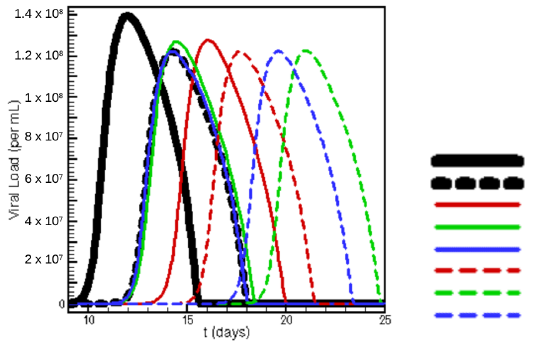
Figure 8. Viral load as a function of time for various treatment regimens. Each efficacy is 90% for Remdesivir (Rem.) and 75% for entry inhibition (HC). In descending order, the legend describes treatment regimens: 0–25 no treatment, 0–25 Rem., 0–5 Rem. 5–25 HC, 0–10 Rem. 10–25